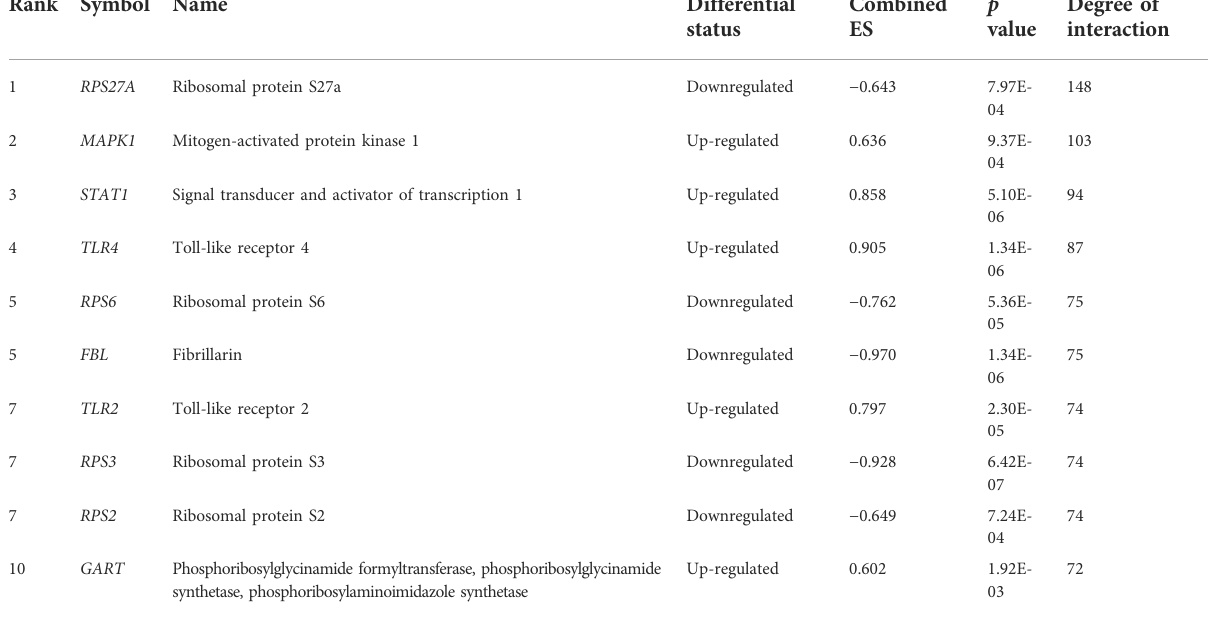
TABLE 4 The differential status of the top ten hub genes with their degree of